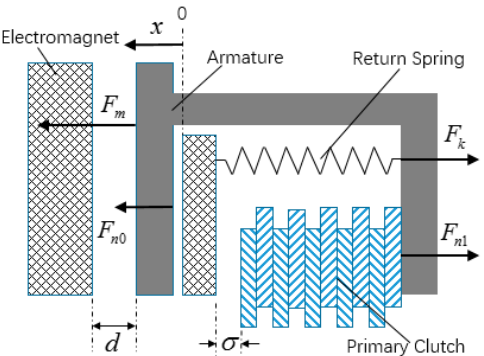
Figure 8. Comparison of the measured and the reference force.